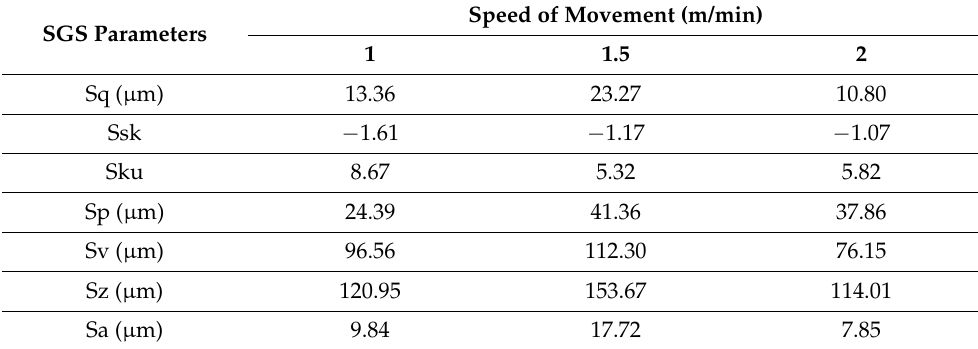
Table 11. Parameters of the SGS after laser alloying (sample